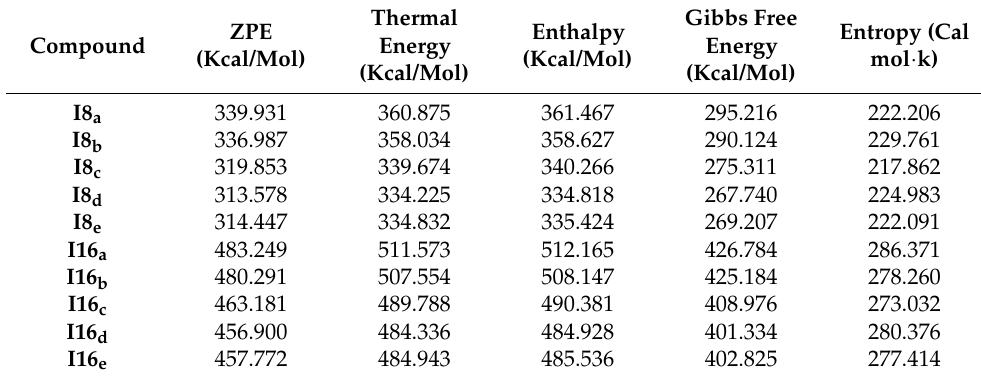
Table 2. Estimated thermal parameters for present series, In x .